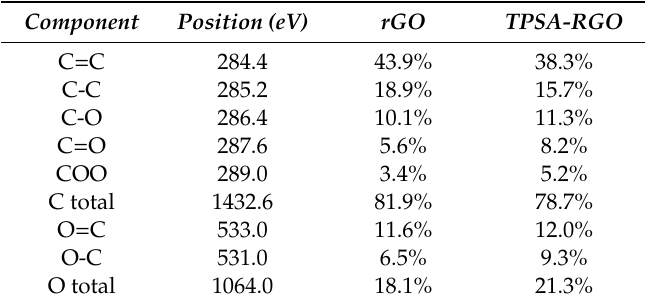
Figure 5. XPS profiles of C1s for ( A ) rGO and ( B ) TPSA-rGO, of O1s for ( C ) rGO and ( D ) TPSA-rGO. Table 1. Components in rGO and TPSA-rGO as determined by XPS analysis